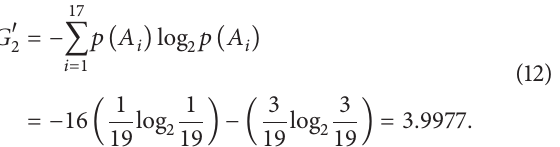
Figure 4: Process control flowchart model for emergency repair of overhead transmission